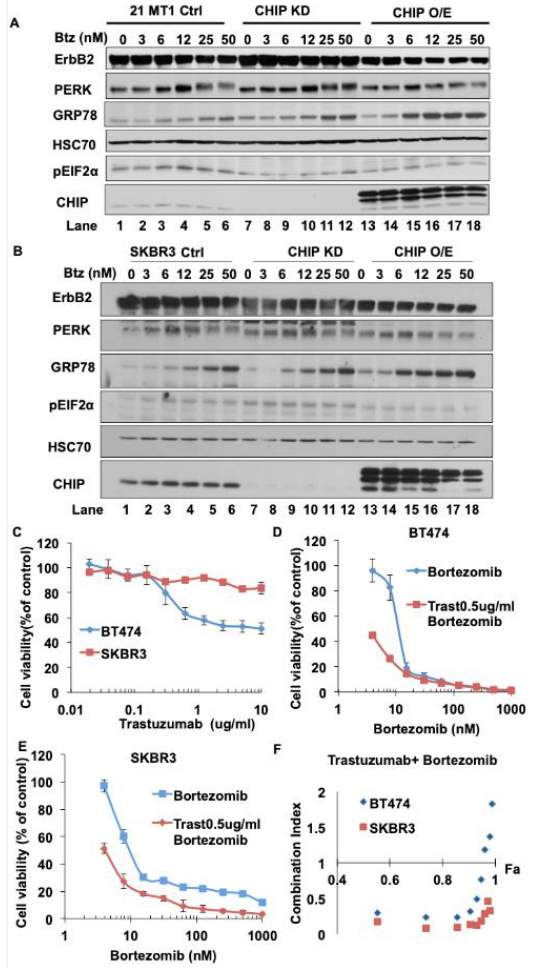
Figure 5. Bortezomib induces ER stress in ErbB2-overexpressing breast cancer cell lines and exhibits synergistic inhibition of cell proliferation when combined with Trastuzumab. ( A , B ) 21MT1 ( A ) and SKBR3 ( B ) cells were seeded in six-well plates and incubated with Bortezomib for 24 h. Cleared lysates (50 µ g/lane) were subjected to Western blotting for ErbB2, GRP78, phospho-eIF2 α , PERK, CHIP and Hsc70 (loading control). ( C – E ) BT474 and SKBR3 cells were seeded in 96-well plates and cultured for 5 days in the presence of either Trastuzumab or Bortezomib alone or combinations of the two at various concentrations. Viable cells were stained with the MTT dye and optical density read at 570 nm wavelength in a plate reader. Data represent mean ± SD, n = 3. ( F ) Combination index was calculated using the CalcuSyn software (http://www.biosoft.com/w/calcusyn.htm; accessed on 16 July 2021 per the method of T.C. Chou and Mike